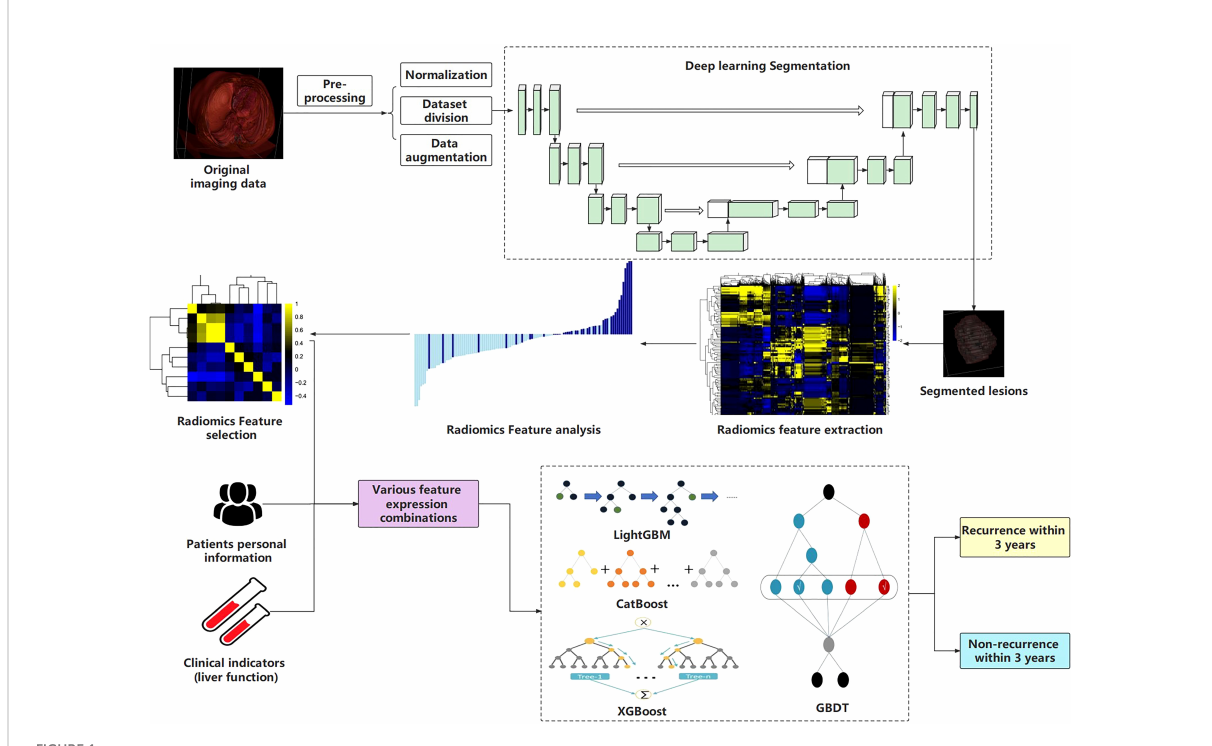
FIGURE 1 The work fl ow of this